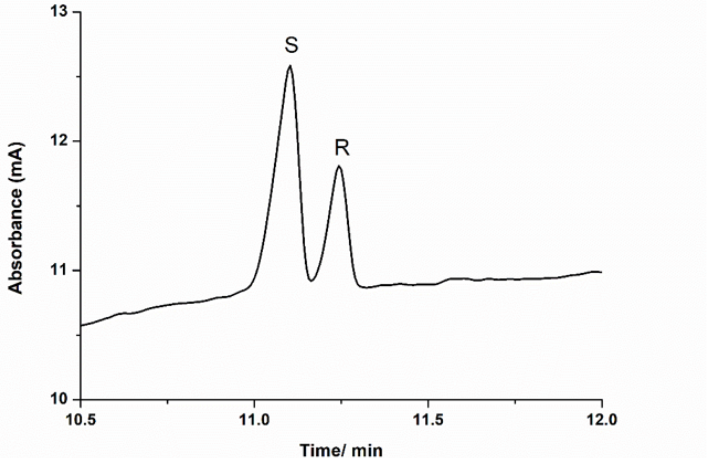
Figure 2. ( A ) Electropherogram of a mixture of ( S )-(in excess) and ( R )-5-hexyl-2-methyl-3,4-dihydro- 2 H -pyrrole. Separation conditions: bare fused silica capillary with a total length of 60 cm (51.5 cm effective) and 50 µm i.d.; background electrolyte of formate buffer (25 mmol L − 1 , pH adjusted to 3.8) and sulfobutyl ether- β -cyclodextrin sodium salt (3% m/v); hydrodynamic sample injection at 50 mbar for 5 s; separation voltage of − 20 kV; UV detection at 210